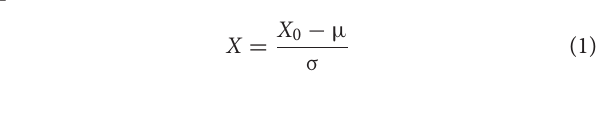
TABLE 1 | Summary of categorical data used for the two pathosystems analyzed: A. flavus -maize and F. verticilloides -maize.